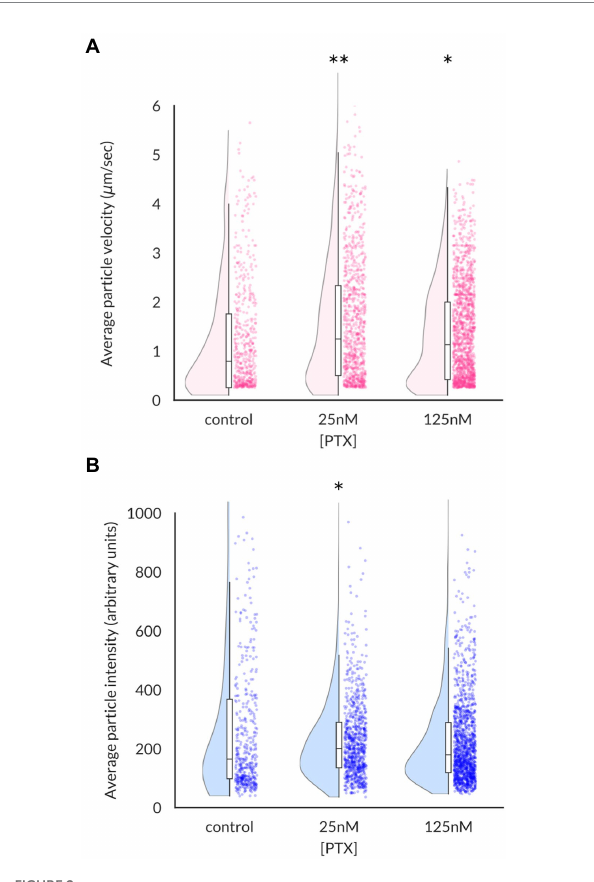
FIGURE 1 Paclitaxel treatment increases Na V 1.8 channels at the surface of distal axons of DRG neurons. (A) Representative maximum intensity projections from confocal stacks of DRG axonal endings in the distal portion of the microfluidic chamber, pseudocolored by fluorescence intensity of labeled Na V 1.8. (B) 24 h of treatment with 25 nM or 125 nM PTX increased surface level of Na V 1.8 at axonal endings ( ** p = 0.009 and * p = 0.011 respectively, by Bonferroni-corrected Mann–Whitney U test). At least 3 independent cultures were analyzed per condition; each point indicates an individual axonal ending (N = 16, 11, and 10 axons, respectively, for each treatment